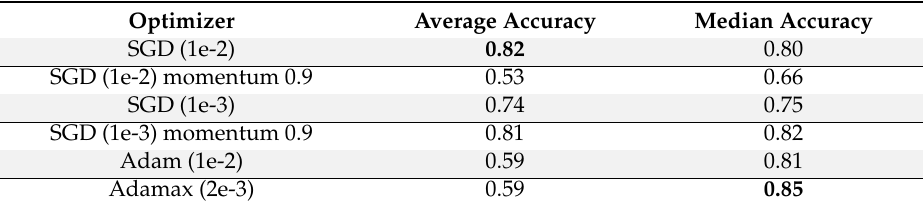
Table 6. Optimizer performance summary.